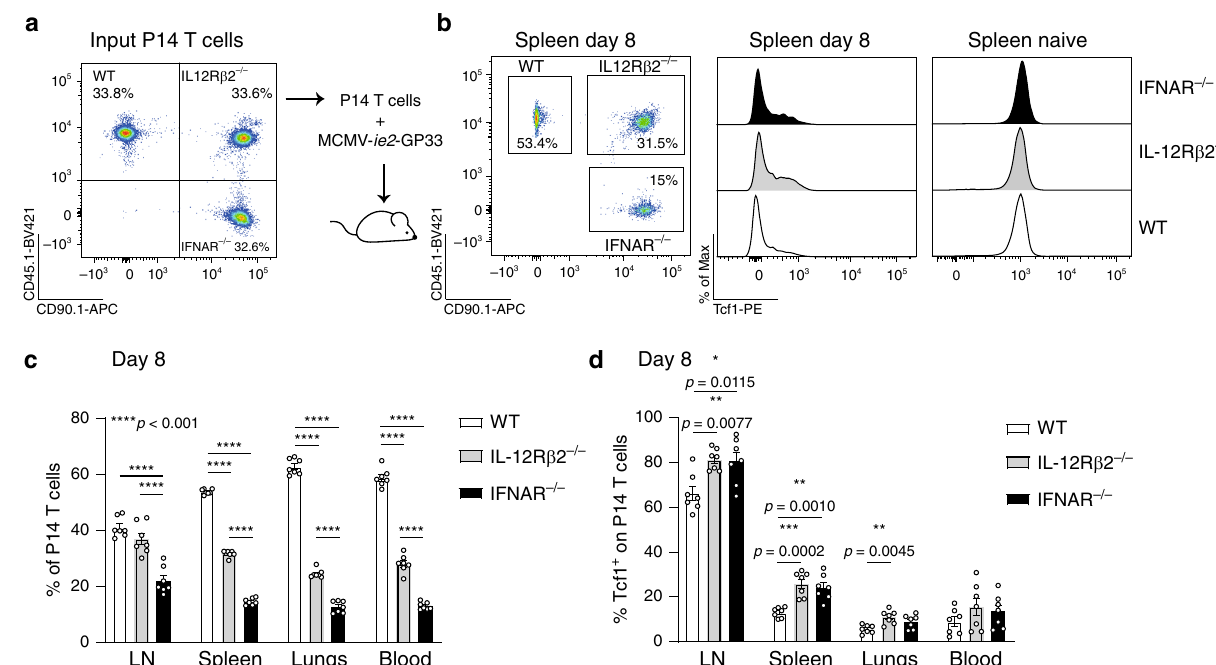
Fig. 3 Type I IFNs and IL12 regulate Tcf1 expression in MCMV-speci fi c CD8 T cells. a Experimental setup: equal numbers of CD45.1 + WT, CD45.1